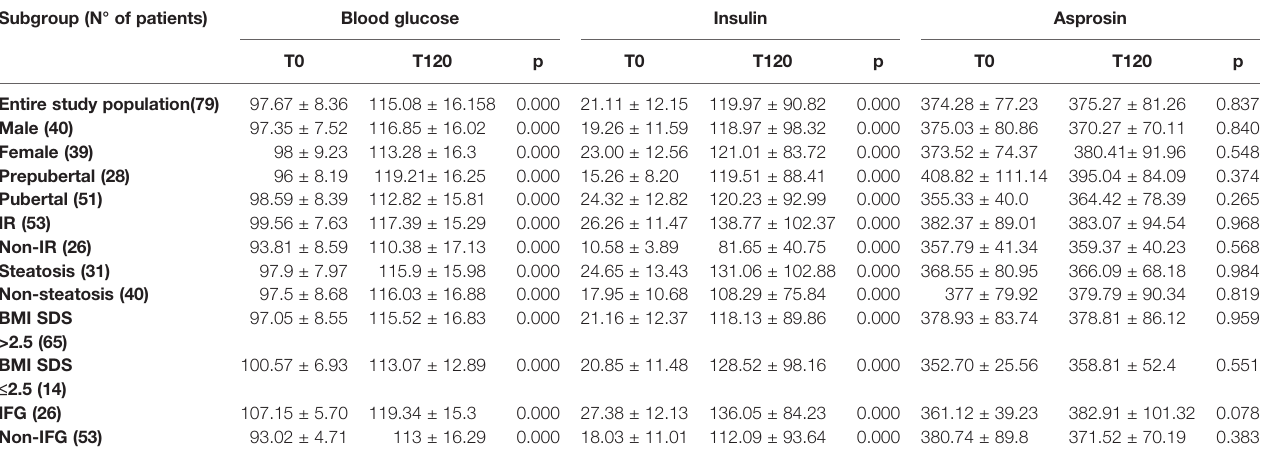
TABLE 2 | Variations in blood glucose, insulin and asprosin between fasting and 2-h postprandial levels. Subgroup (N° of patients) Blood glucose Insulin